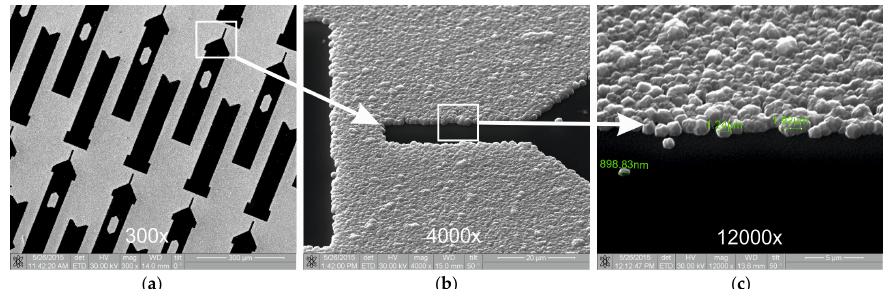
Figure 6. SEM image of the produced film (0.45 wt % of nanodiamond particles in photoresist and 4 min treatment by reactive ion etching) edge with different magnifications: ( a ) 300×, ( b ) 4000×, and ( c ) 12,000×.